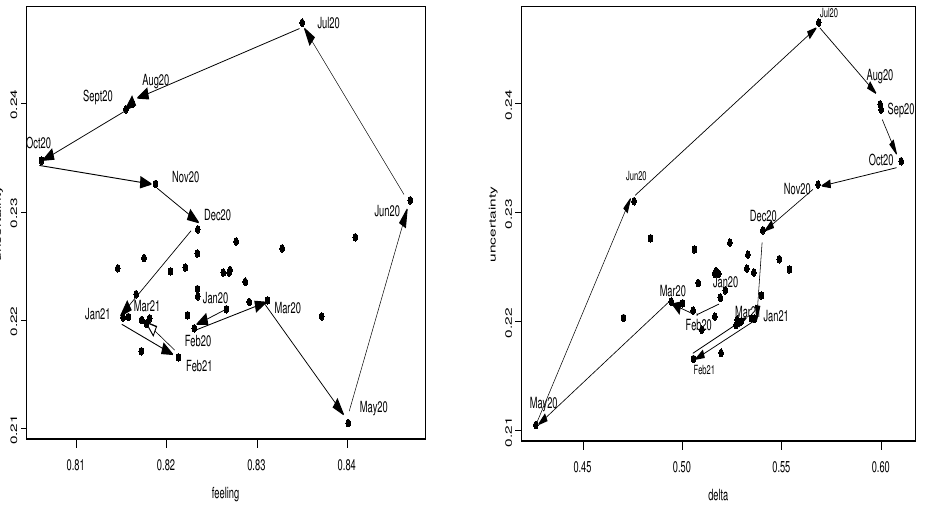
Figure 3. Inflation expectations: scatterplot of ( 1 − ˆ π t ) vs. ( 1 − ˆ ξ t ) ( left panel ); ( 1 − ˆ π t ) vs. ˆ δ t ( right panel